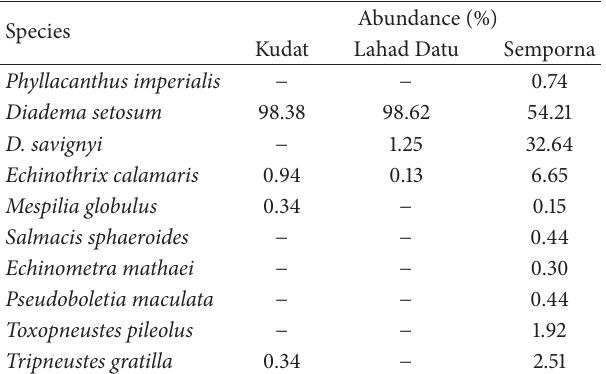
Table 5: The species abundance (%) of sea urchins according to districts, ( − ):